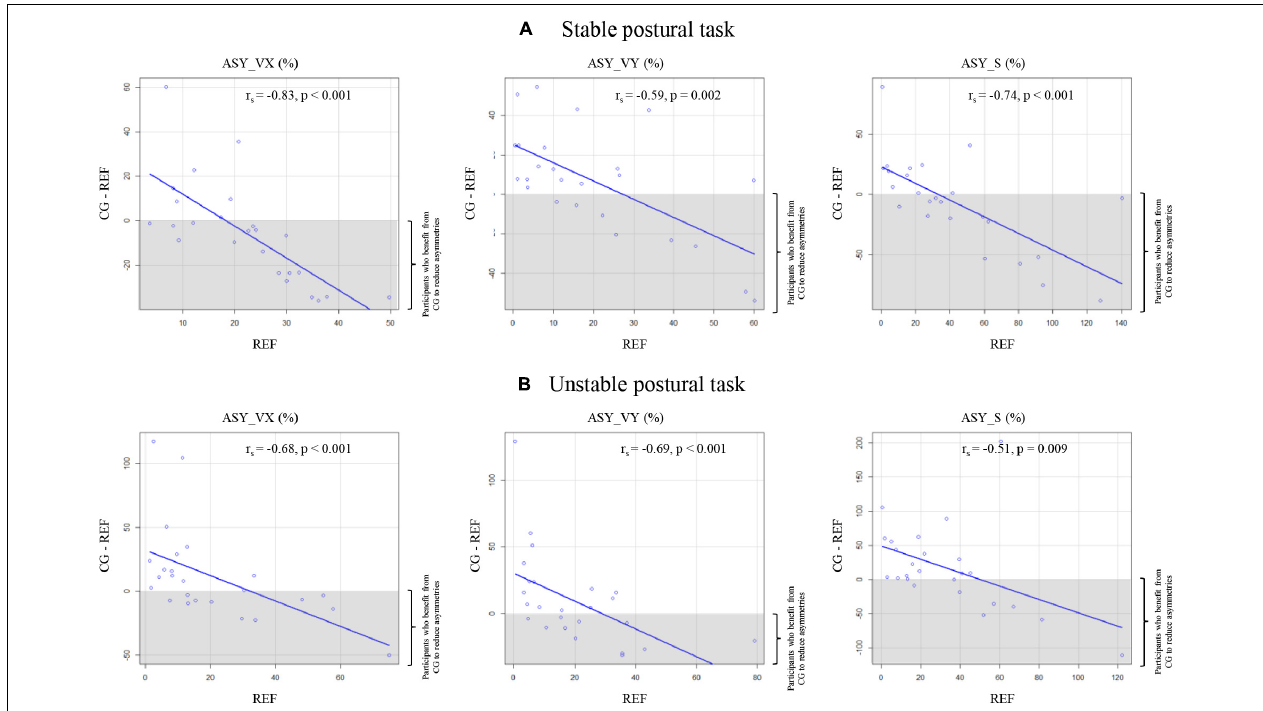
FIGURE 3 | Scatterplots representing the correlations between asymmetry indexes (ASY_VX, ASY_VY, and ASY_S) in the REF condition and the differences in asymmetry between REF and compression garments (CG) conditions (CG–REF) in (A) the stable postural task and (B) the unstable postural task. Gray areas correspond to participants who benefit from CG wearing to reduce inter-limb balance asymmetries (negative difference). Blank areas correspond to participants who do not benefit from CG wearing to reduce inter-limb balance asymmetries (positive difference). r s : Spearman’s rank correlation